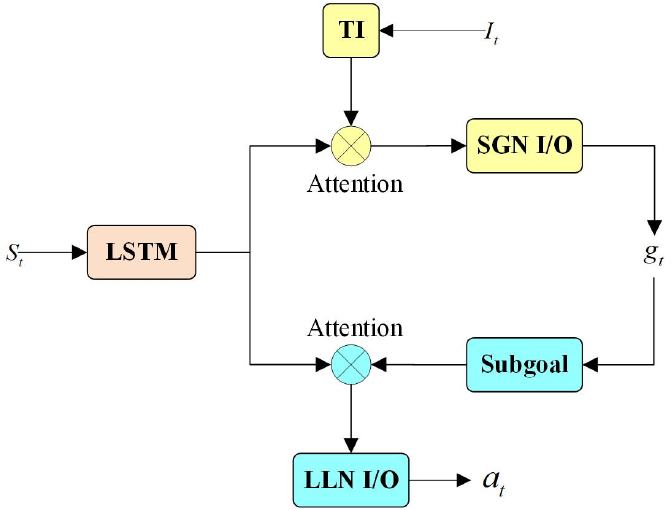
Figure 3. HRL-DCS network structure.